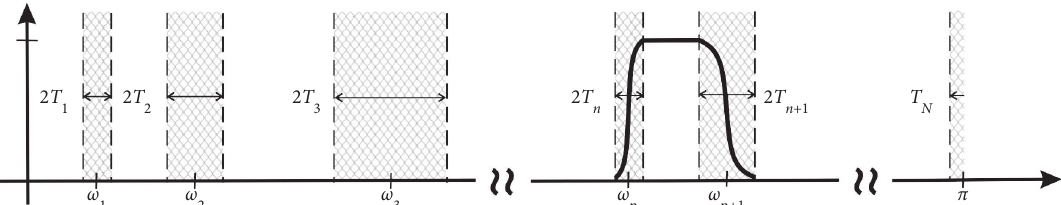
Figure 1: Partitioning of the Fourier axis (modified from